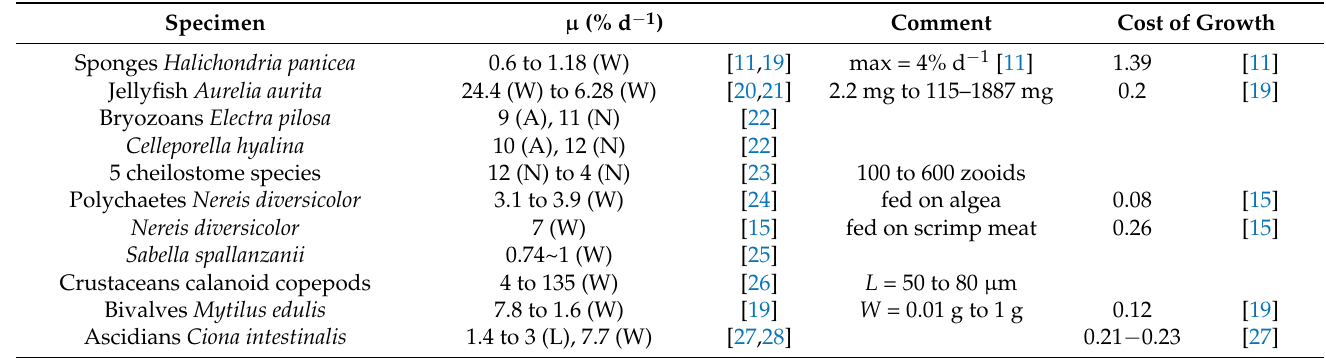
Table 2. Specific growth rates of some filter-feeding marine invertebrates. Growth is measured as the change in size of the following: (W) = dry weight, (A) = colony area, (N) = number of zooids, (L) = body length. Cost of growth = R g / G